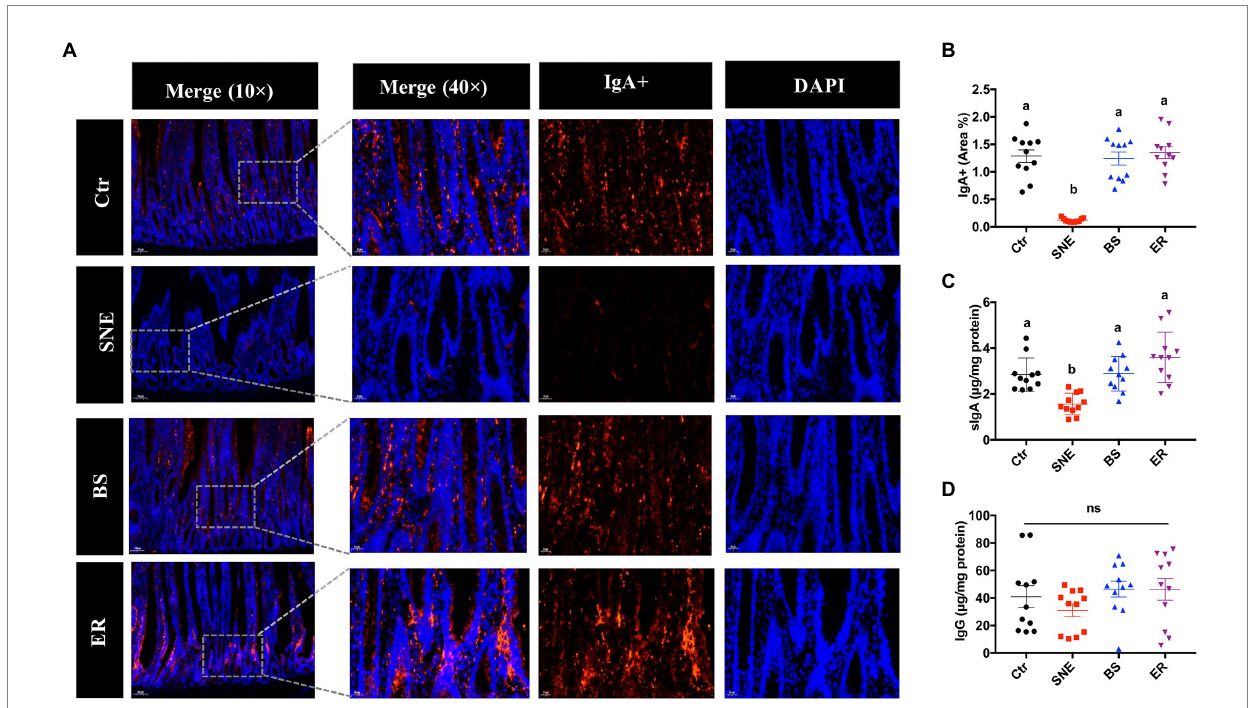
FIGURE 4 (A) IgA+ B cell abundance within the lamina propria in the jejunum under original magnification (×10 and ×40). (B) Relative quantification of the immunofluorescence results. (C) Changes in sIgA (D) and IgG levels in the jejunum. (a, b) Mean values with unlike letters between different groups are significantly different ( p < 0·05). ns, not significant. SEM, standard error of mean. Each value represents the mean ± SEM of 12 replicates ( n = 12). The abbreviation of Ctr, SNE, BS and ER have the same meaning as Table 3.